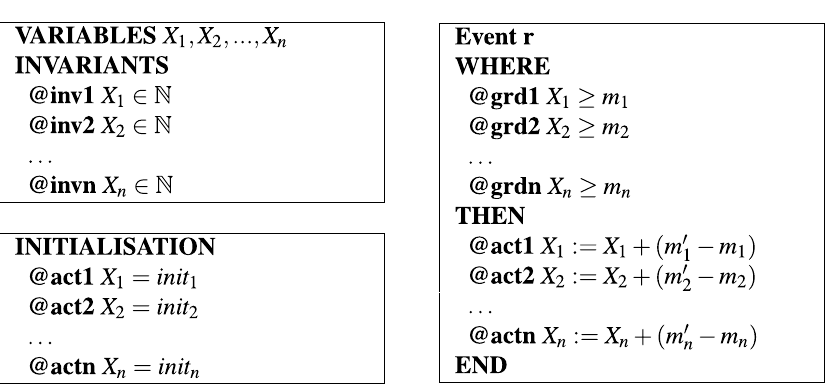
Table 1. The general form of an Event-B model for a reaction network. The event r models reaction (1), implementing the result of that reaction being